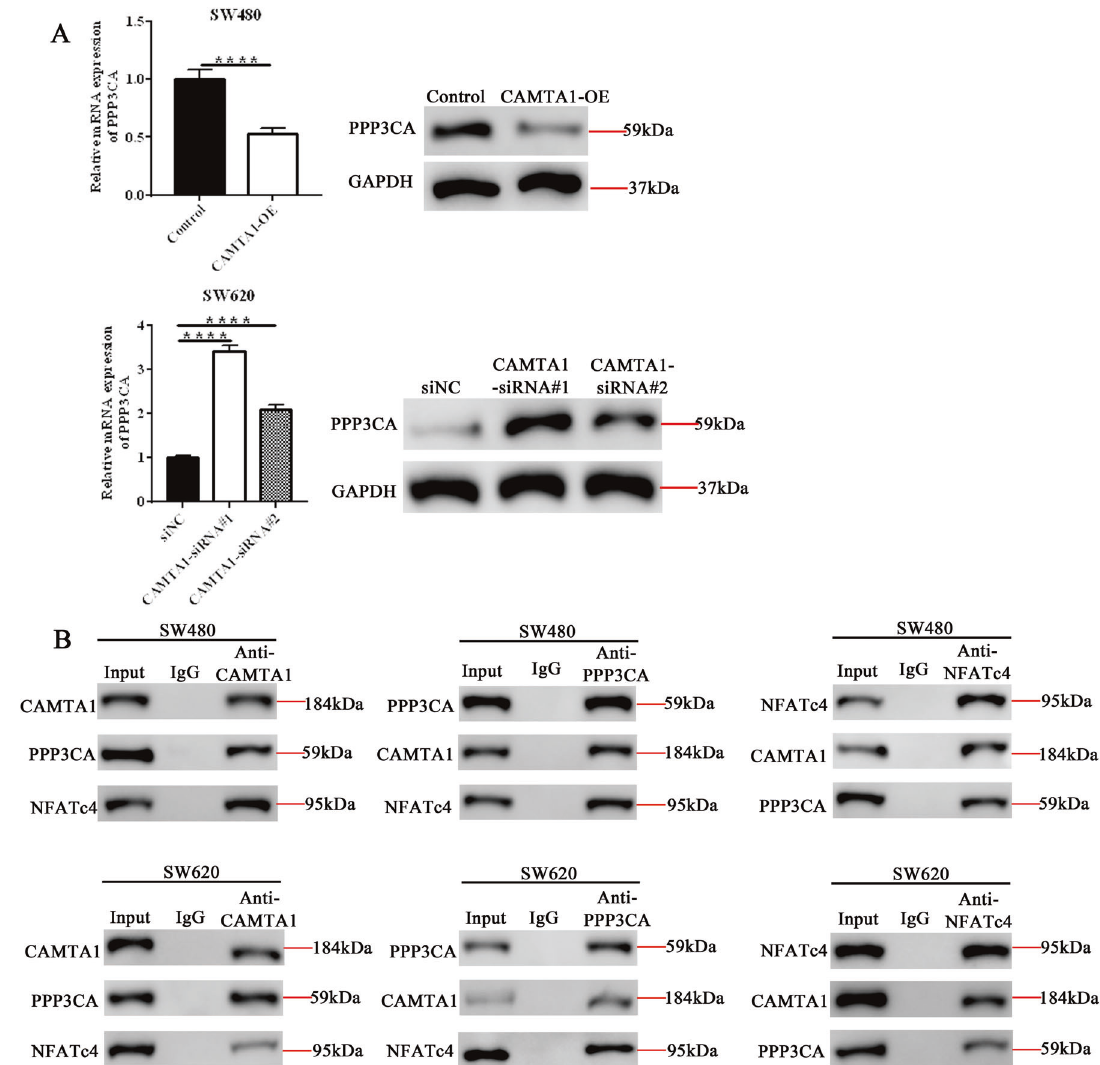
Fig. 6 CAMTA1 directly interacts with NFATC4 and PPP3CA and upregulates PPP3CA expression in colorectal cancer cells in vitro. A qPCR (left panel) and western blotting (right panel) analyses of PPP3CA mRNA and protein levels in CAMTA1 -overexpressed SW480 (top panel) and CAMTA1 -silenced cells (bottom panel), respectively. GAPDH served as the internal control for data normalization. B Co-immunoprecipitation and western blotting analyses of interactions among CAMTA1, NFATC4, and PPP3CA in SW480 (top panel) and SW620 (bottom panel) cells. Input IgG served as the internal